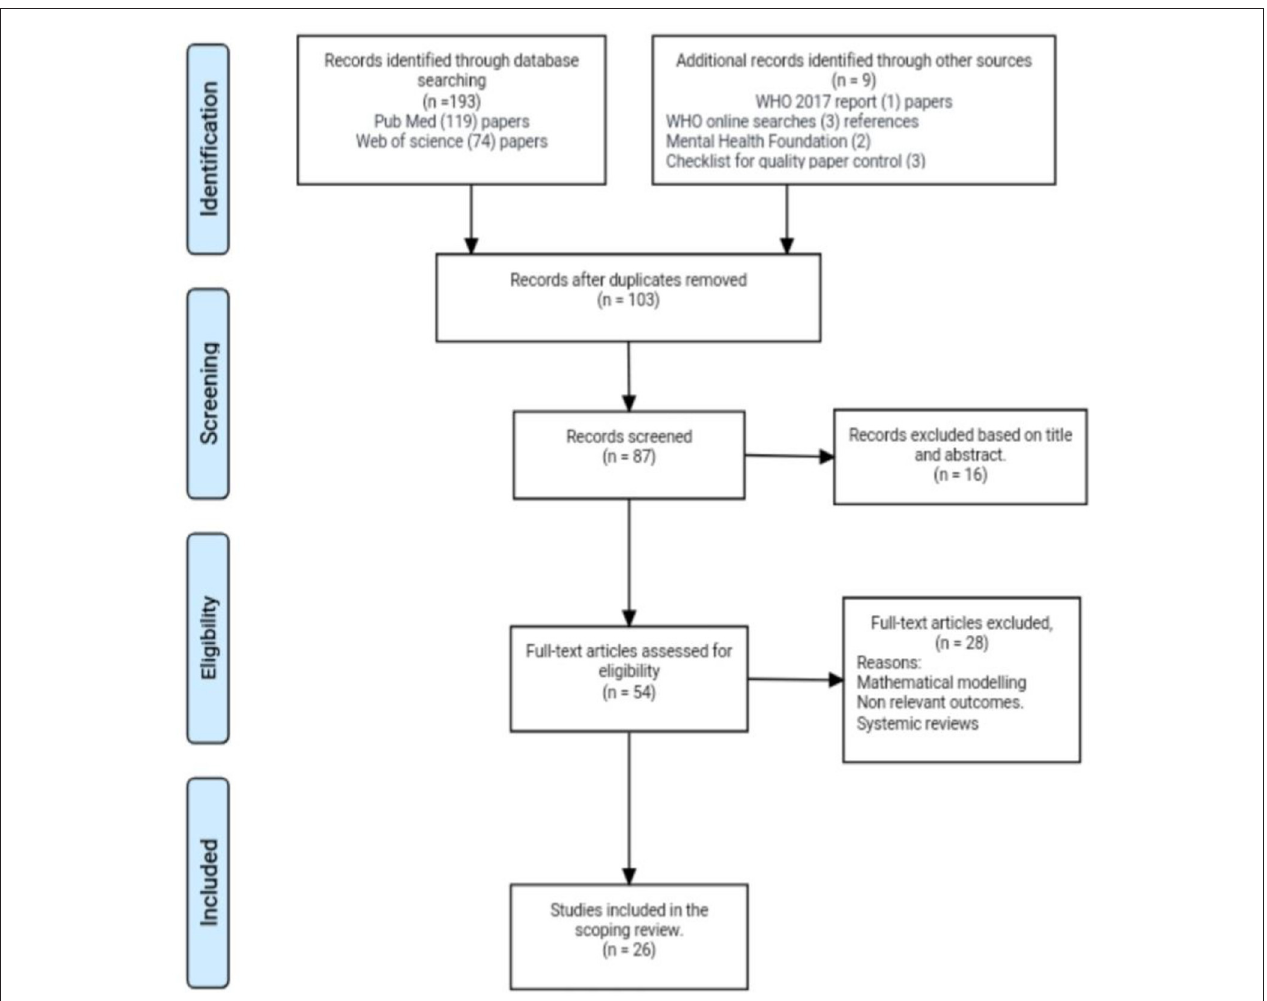
FIGURE 1 | Preferred Reporting Items for Systematic Reviews and Meta Analyses (PRISMA) flow diagram for scoping